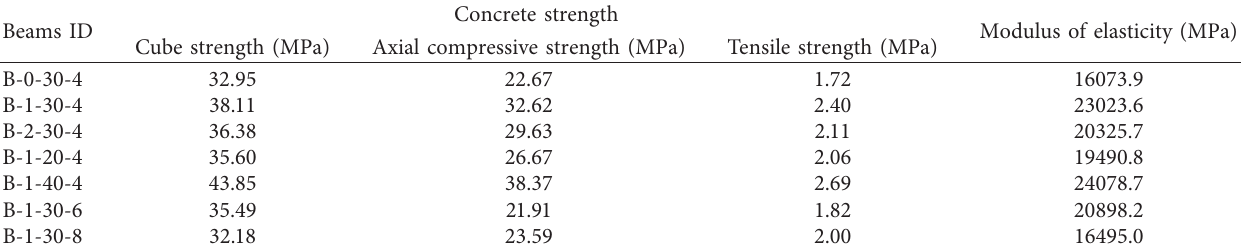
Table 2: Mechanical performance index of concrete.